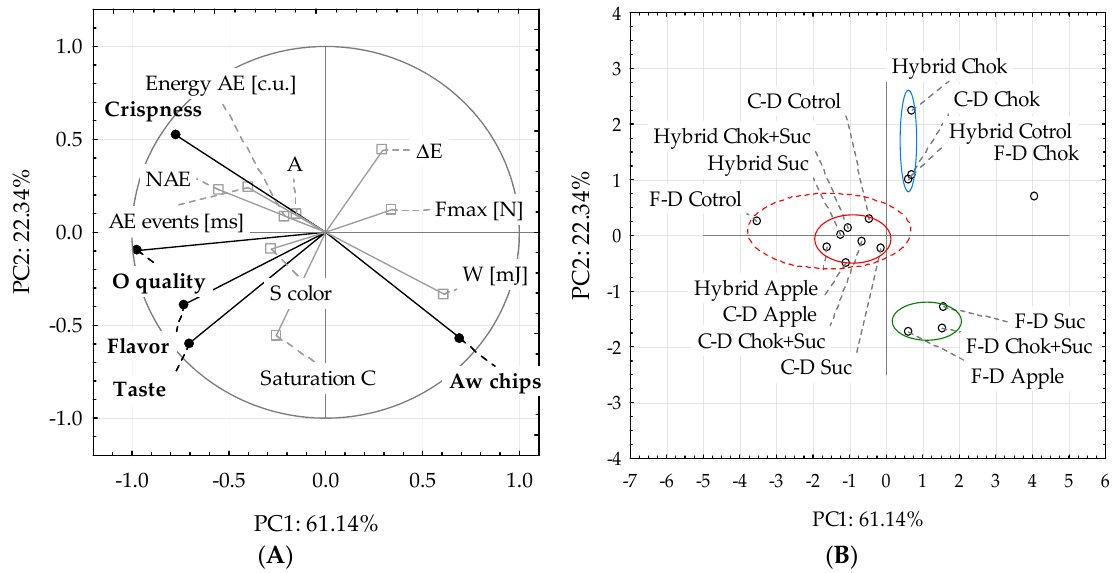
Figure 8. Principal component analysis (PCA) analysis: ( A ) PCA diagram; ( B ) similarities and differences. Meanings: O quality—overall quality, S color—color sensory evaluation, saturation C—color saturation parameter.